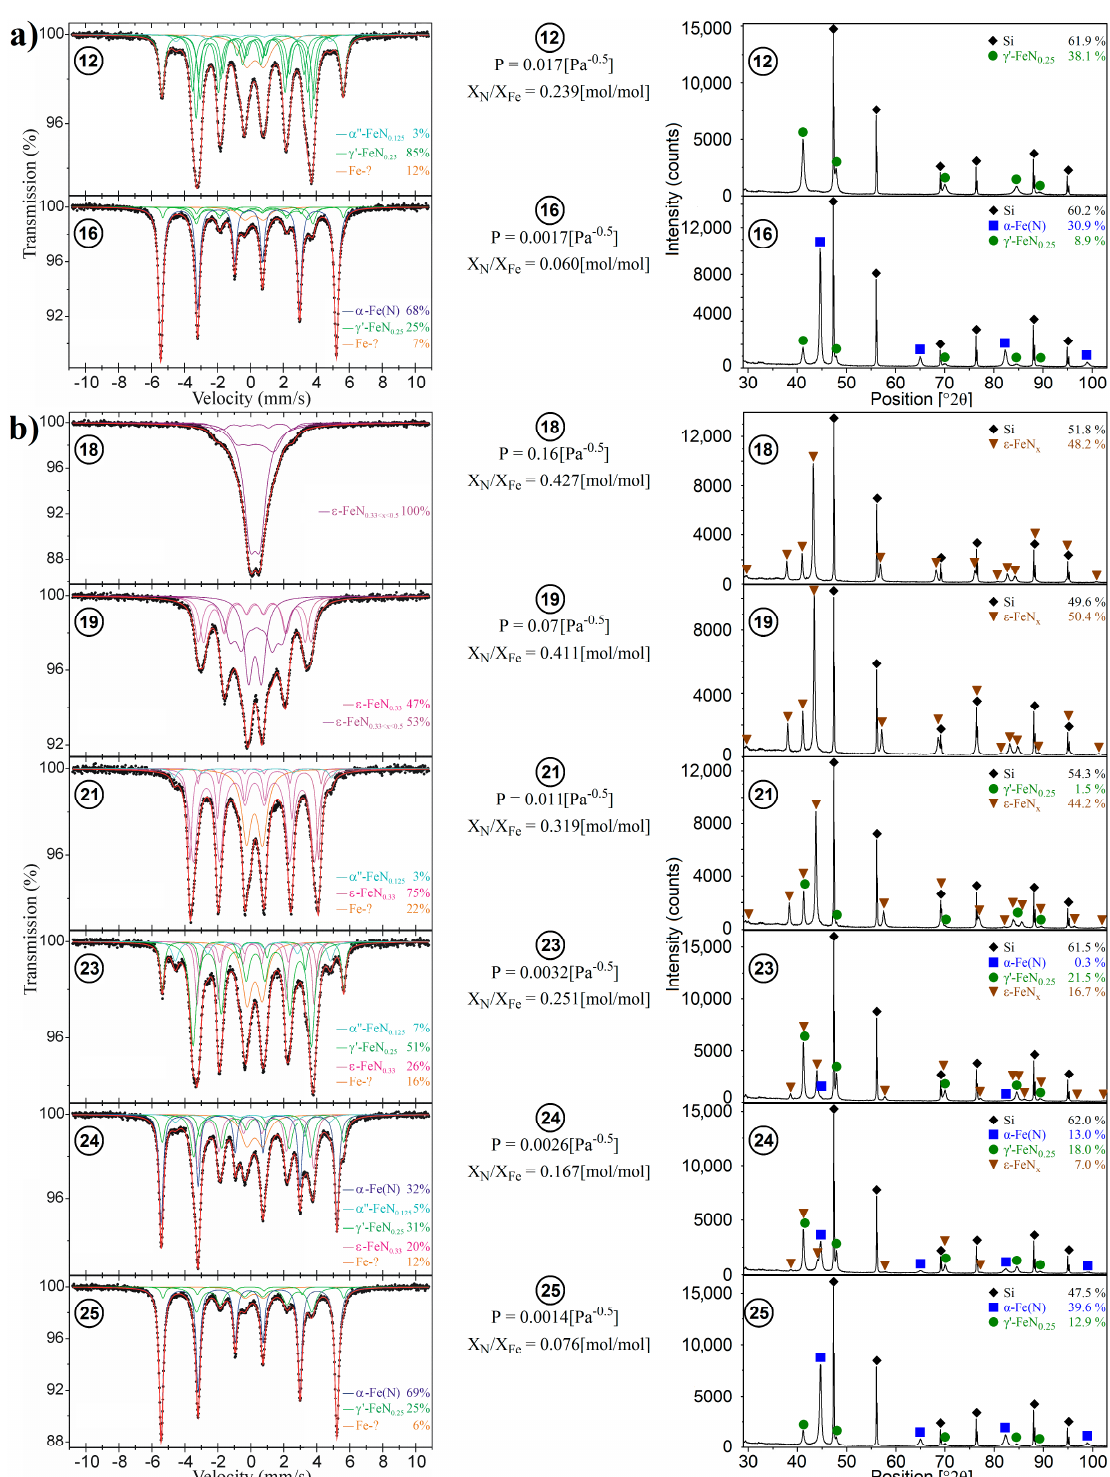
Figure 2. The comparison of 57 Fe Mössbauer spectra and X-ray di ff ractograms for selected samples obtained during the processes of: reduction of: a mixture of nanocrystalline nitrides γ ’-FeN 0.25 and α ”-FeN ζ -FeN 0.125 ( a ) and nanocrystalline nitride 0.5 ( b